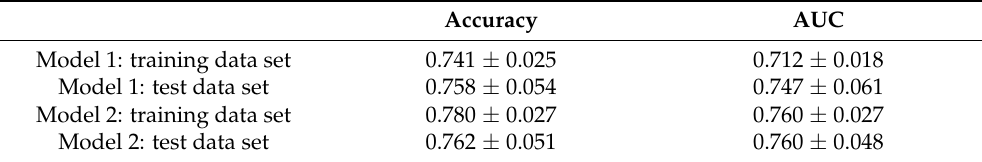
Table 1. Results of random forest classification model for individual EL productivity.